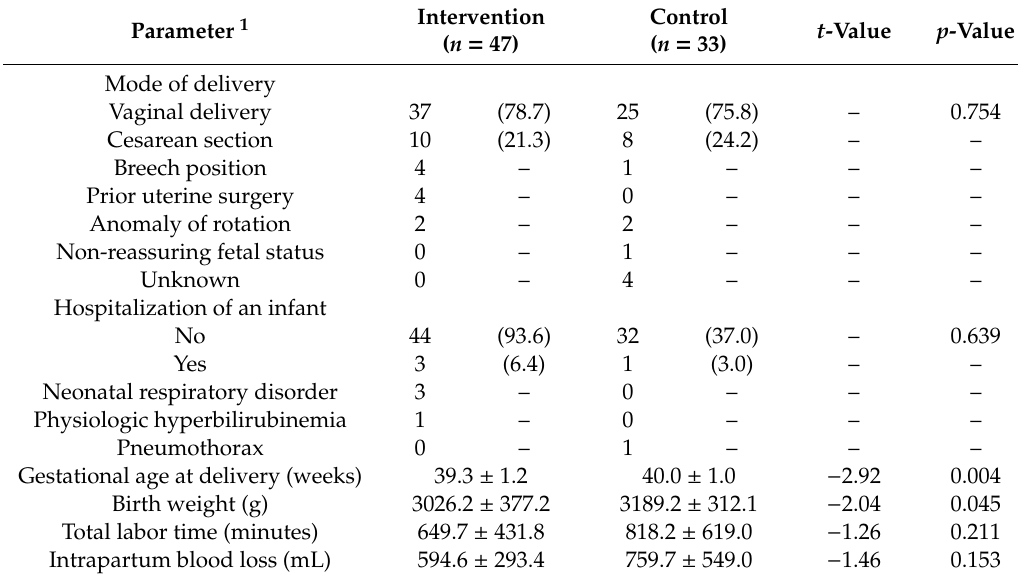
Table 2. Pregnancy and delivery